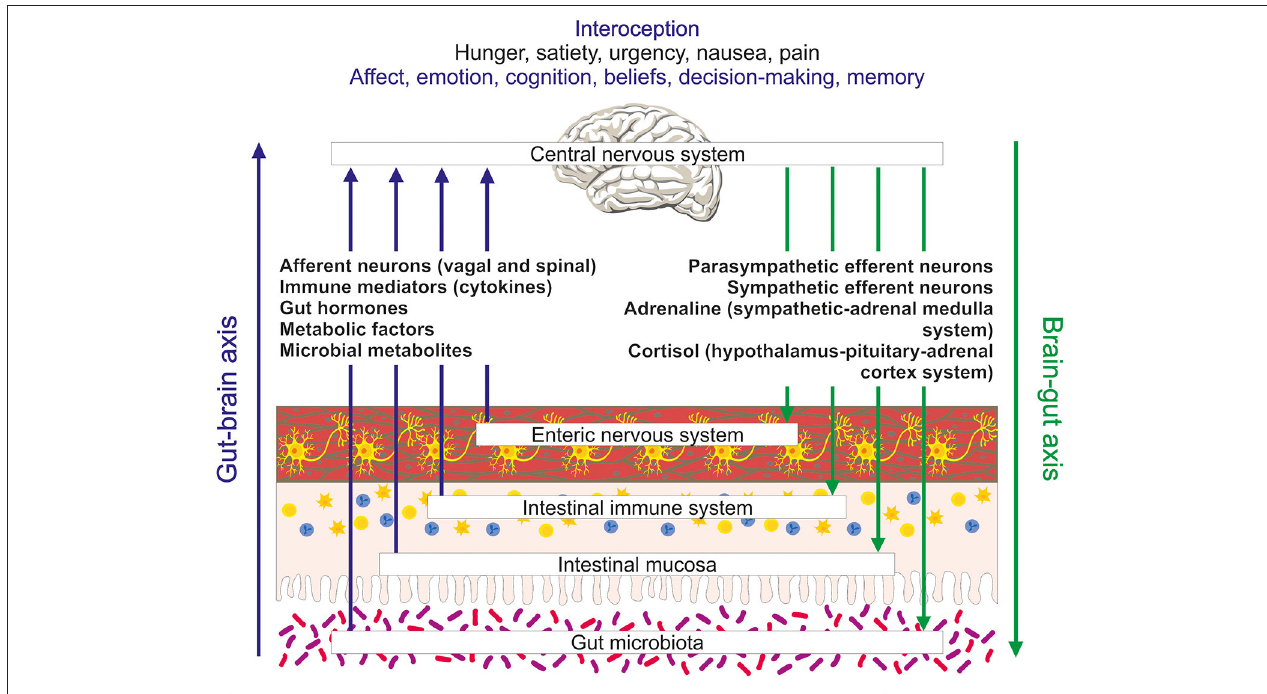
FIGURE 1 | Schematic illustration of the bidirectional exchange of information between the gut and brain and the interoceptive processing of this information in the brain. Several messenger systems including extrinsic afferent neurons, immune mediators, gut hormones, metabolic factors and microbial metabolites carry information from the gut to the brain. They elicit conscious sensations (e.g., hunger, satiety, urgency, nausea, and pain) and influence processes relevant to affect, emotion and cognition. Regulatory outputs from the brain to the gut include emotion- and stress-related changes in motility, secretion, blood flow and